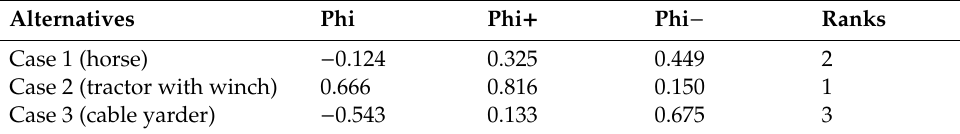
Table 11. MCDA results for application of PROMETHEE